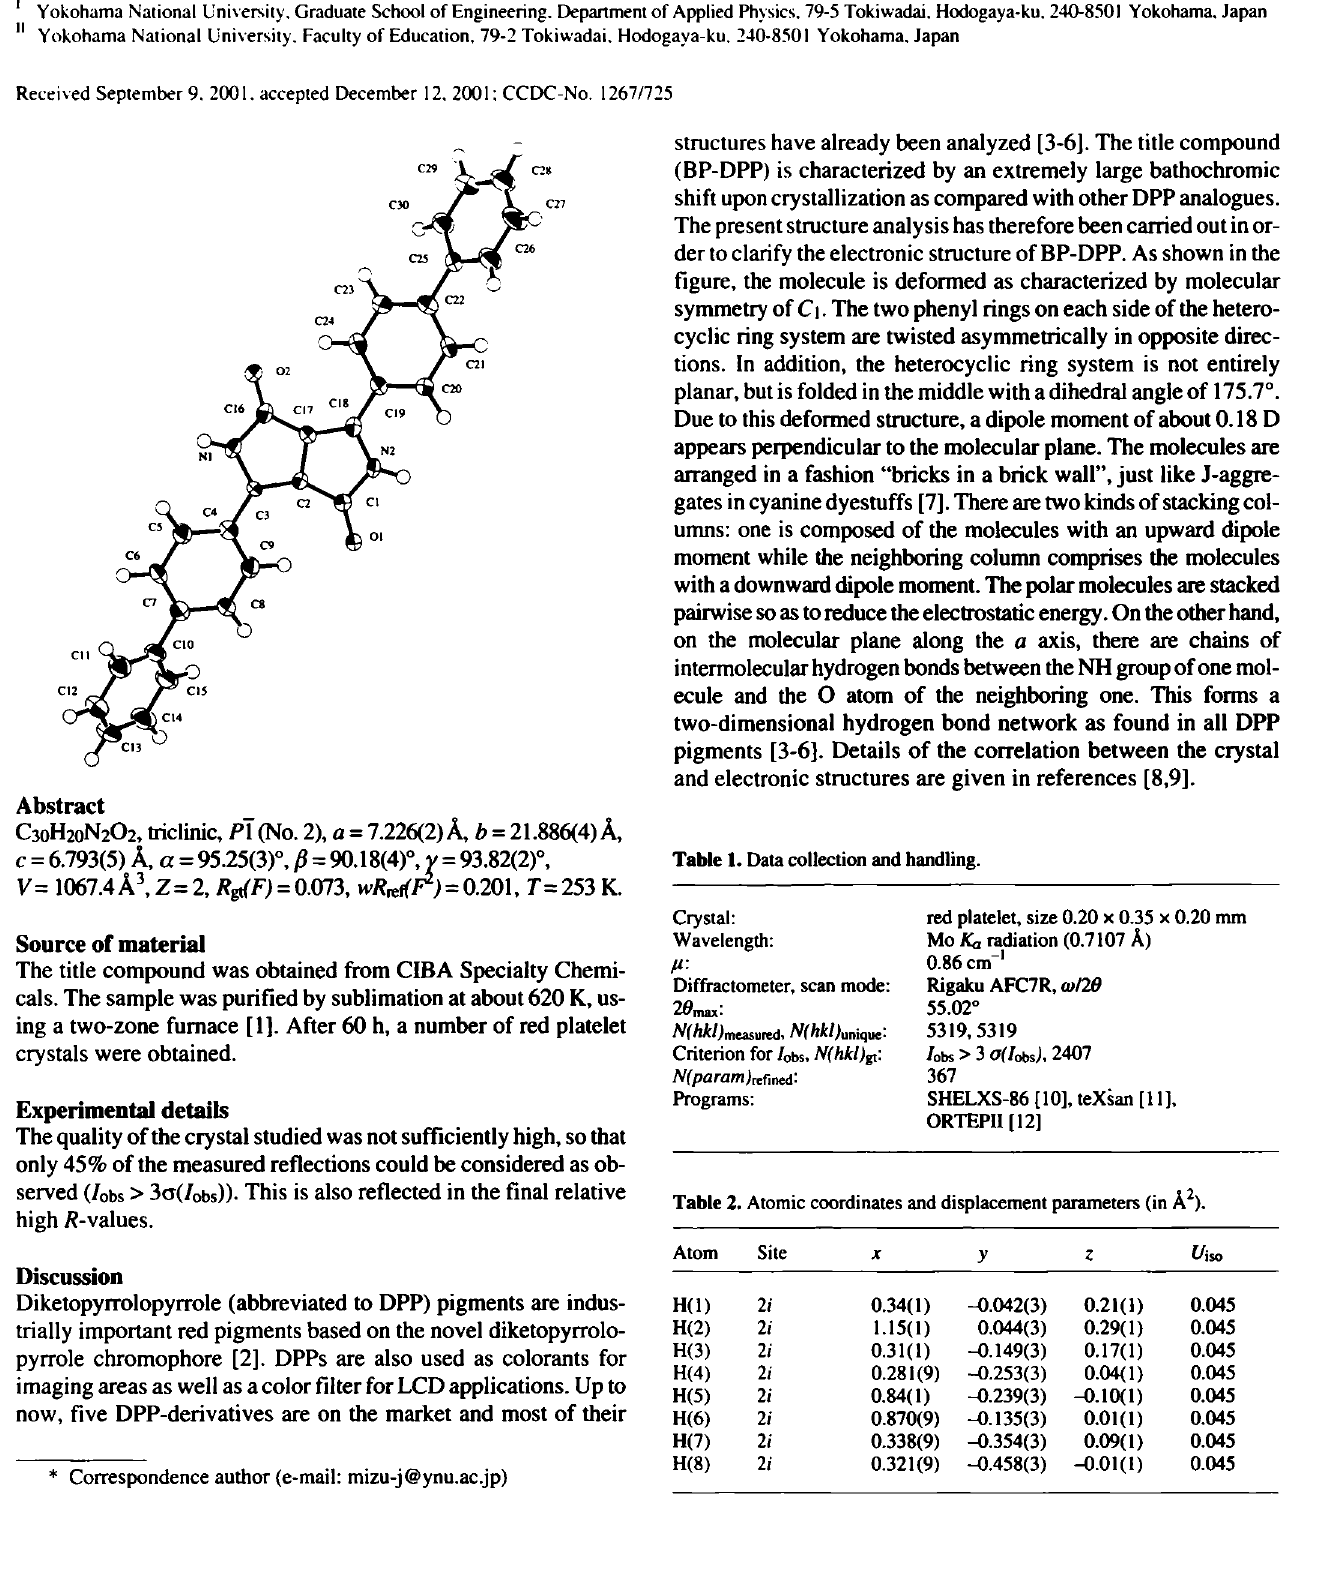
Table 2. Atomic coordinates and displacement parameters (in A 2